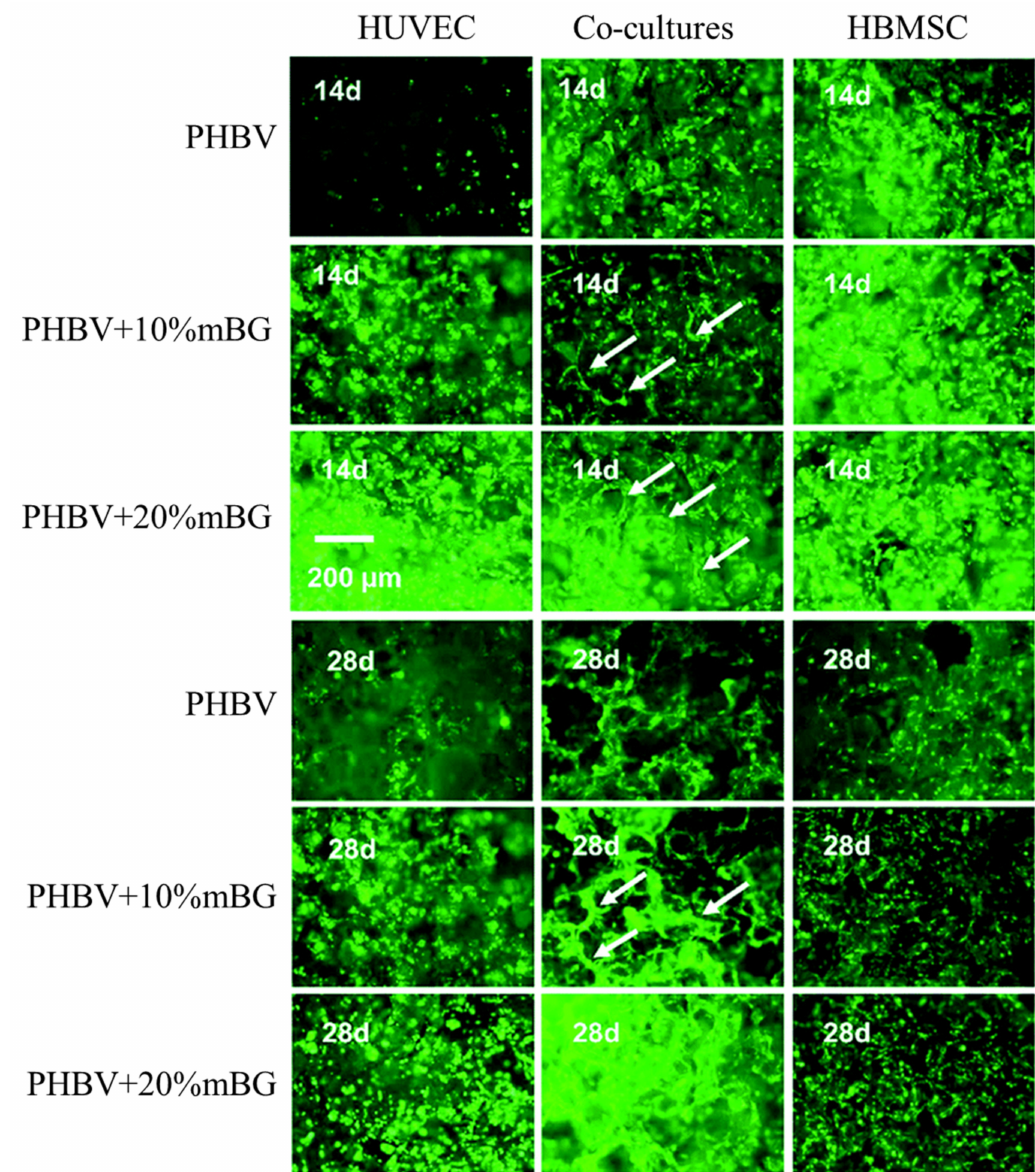
Figure 9. Live-dead staining of cells cultured in different scaffolds for 14 and 28 days. Reproduced from [97] with permission from the Royal Society of Chemistry. This article is licensed under a Creative Commons Attribution 3.0 Unported